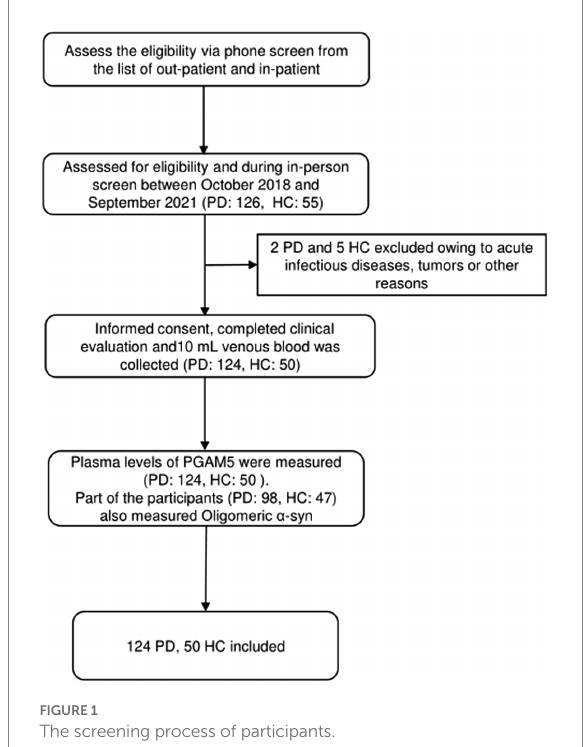
FIGURE 1 The screening process of